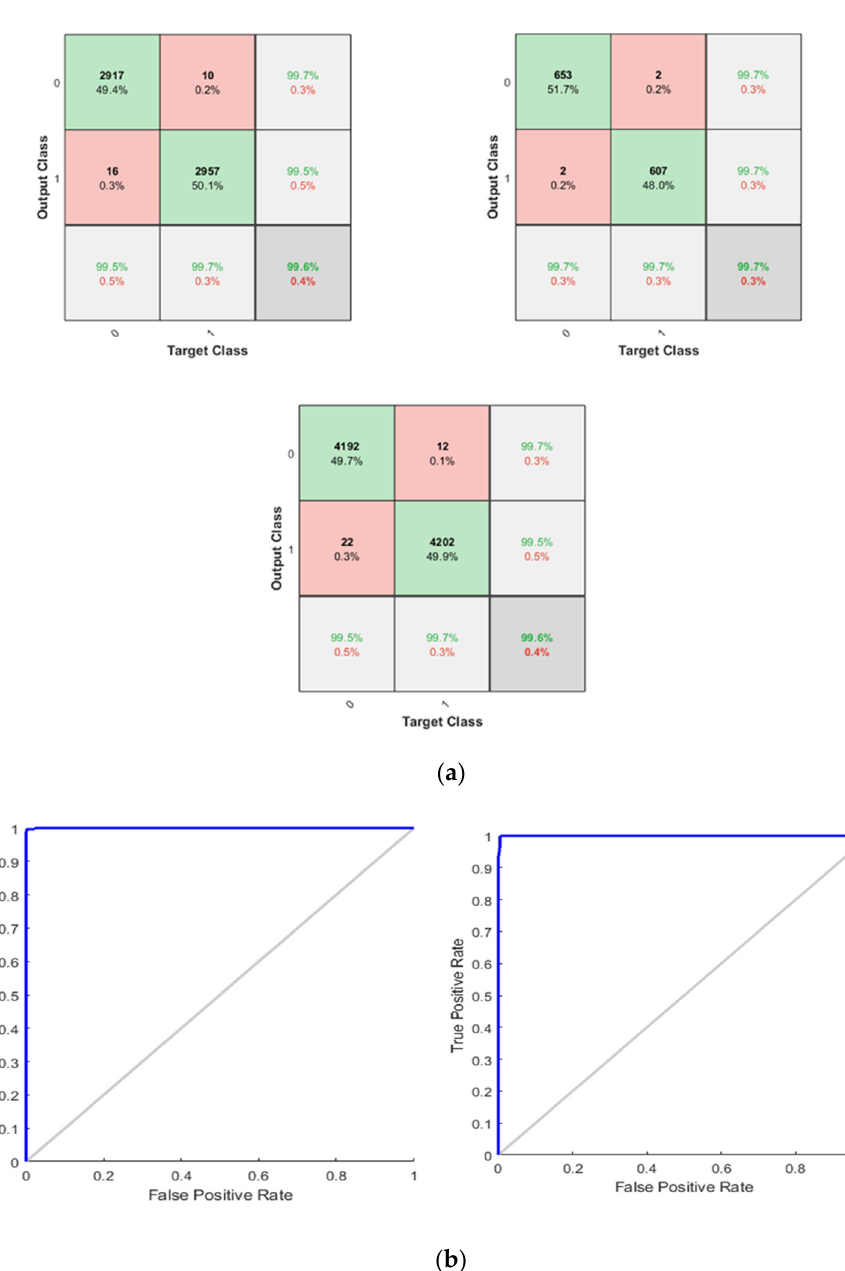
Figure 10. ( a ) The confusion matrixes (over the synthetic PPG composed by subject signal and reference signal) related to some recruited subjects. The proposed pipeline is able to discriminate with 99.6% to 99.7% accuracy the correct car-driver identity (Class 1, subject and Class 0, PPG reference of RD-M); ( b ) The ROC curves of some further tested subjects are reported.